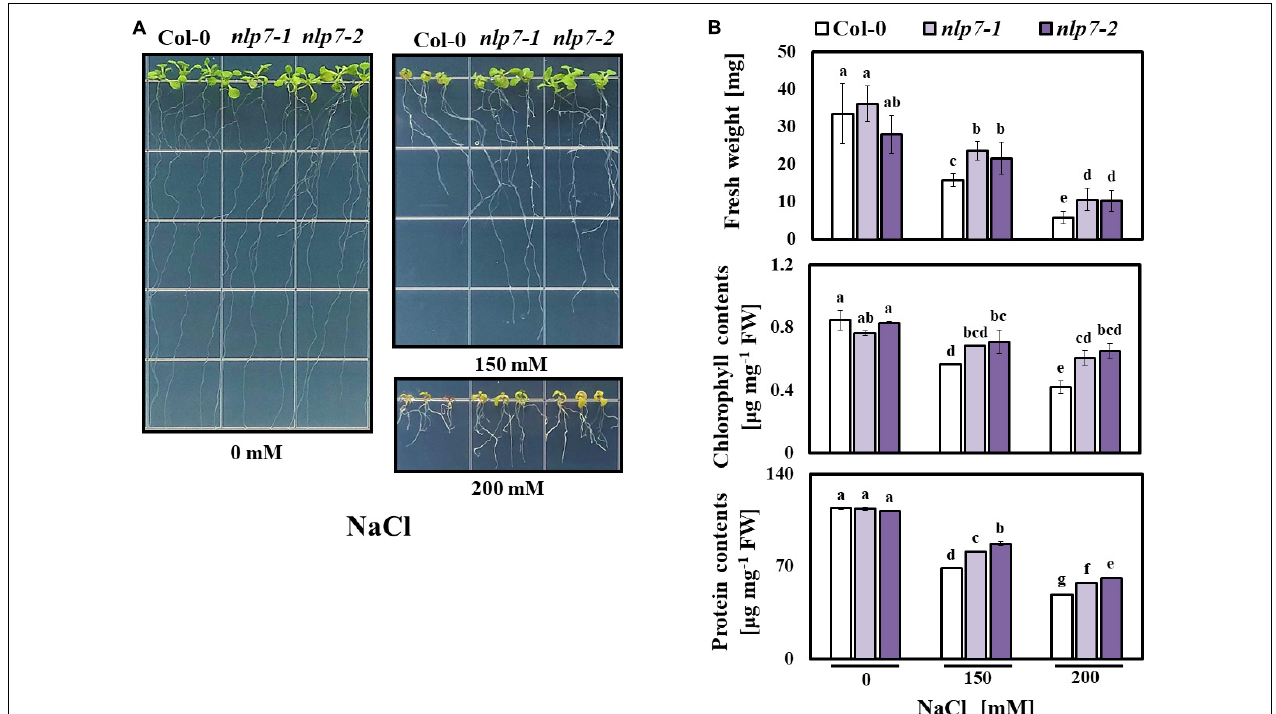
FIGURE 1 | The nlp7 mutants showed enhanced salt tolerance. (A) Comparison of the growth performance of Col-0 and nlp7 plants under salt stress. Four-day-old Col-0, nlp7-1 , and nlp7-2 seedlings were germinated and grown on a nitrogen-free half-strength MS medium containing 5 mM KNO 3 and then transferred to a media supplemented with 0, 150, or 200 mM NaCl. After 2 weeks, each phenotype was confirmed. (B) Quantification of fresh weight, chlorophyll content, and protein content of Col-0, nlp7-1 , and nlp7-2 seedlings in response to salt stress. Error bars represent the standard deviation of three biological replicates. Different letters (a, b, c, or d) within a treatment group indicate significant differences in the two-way ANOVA ( P ≤ 0.05, Tukey’s